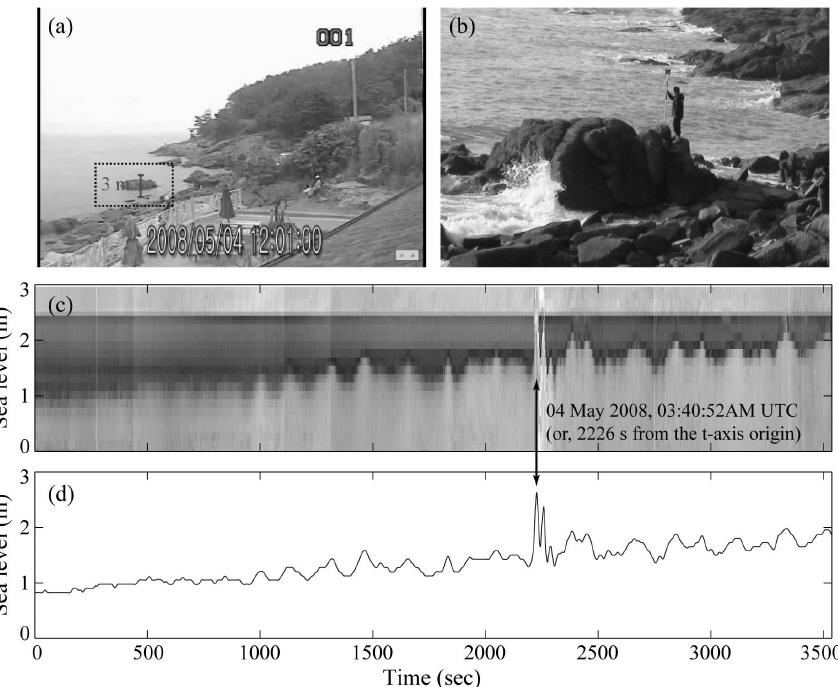
Fig. 4. (a) A rock column (shown in dotted rectangle) sticking out of the sea surface to quantify the vertical tsunami oscillations at the entrance of the Jukdo pocket beach, (b) scaling the lock height in image frame using the field measurement, (c) image timestack generated along the vertical 3m high transect in (a) from the first video data burst, (d) time-series of sea-level variations extracted from the image timestack in (c) by means of the Canny edge detection method.